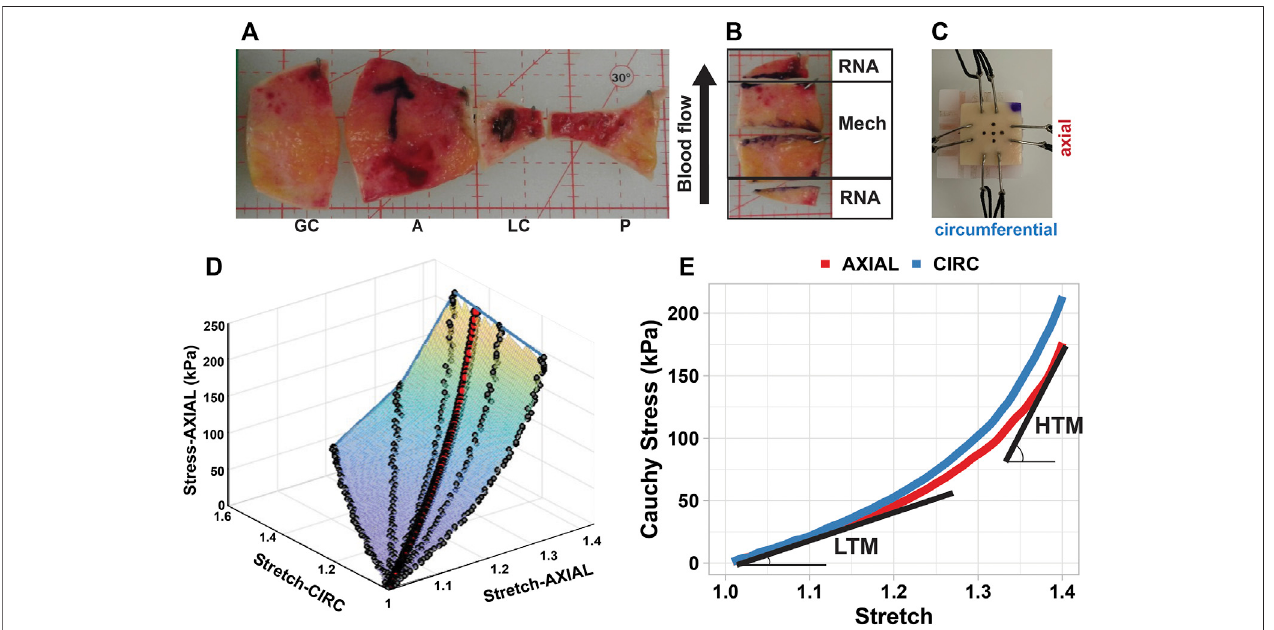
FIGURE 1 | Aneurysm specimen processing and biaxial mechanical testing methodology. (A) whole aneurysms were divided into circumferential regions: greater curvature (GC), anterior (A) , lesser curvature (LC), and posterior (P); (B) tissue was divided into specimens based on the size of the region, with large pieces used for mechanical testing, and adjacent pieces used for RT-qPCR analysis; (C) hook placement on a square biaxial specimen, showing dot placement used for camera tracking; (D) stress-strainsurfaceobtainedfrom fi ttingallexperimentalprotocols,withthereddotsrepresentingthetrueequi-stretchcurveintheaxialdirection; (E) stress-stretch curves obtained inaxial(red) andcircumferential (blue)directionswerecharacterizedbythelow-straintangentialmodulus(LTM)andhigh-strain tangential modulus (HTM). CIRC, circumferential direction; AXIAL, axial direction.